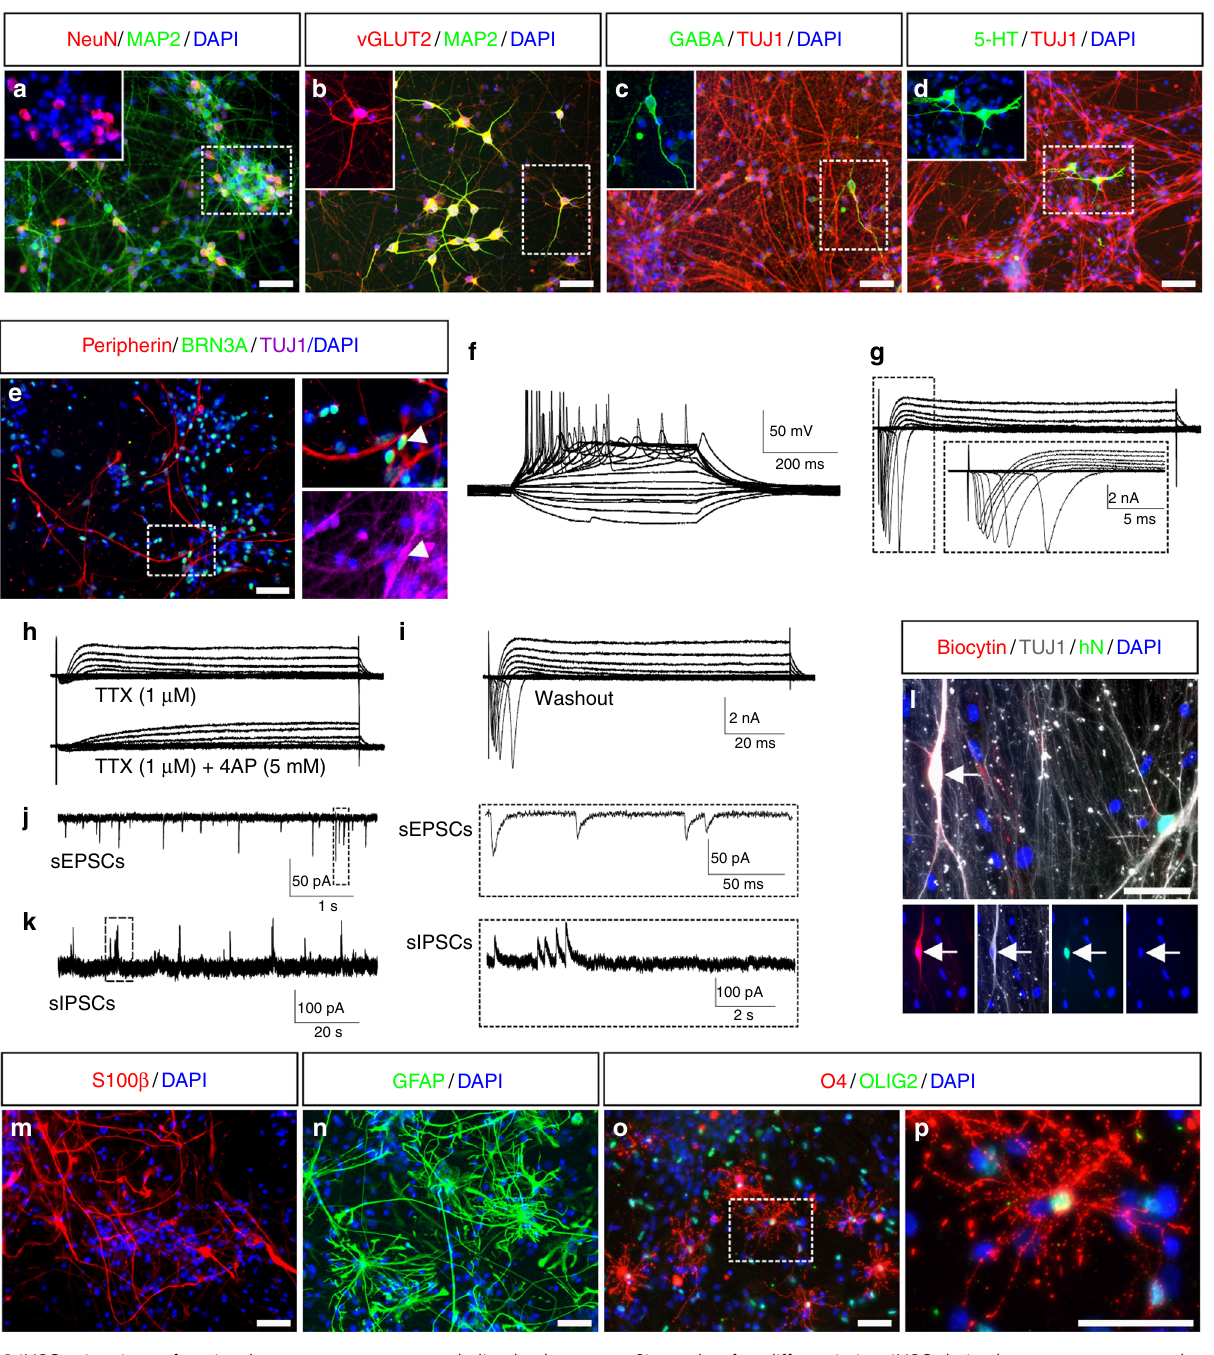
Fig. 2 iNSCs give rise to functional neurons, astrocytes, and oligodendrocytes. a Six weeks after differentiation, iNSC-derived neurons express markers of mature neurons such as MAP2 and NeuN. b – d Upon spontaneous differentiation, iNSCs give rise to vGLUT2-positive glutamatergic neurons ( b ). In addition, staining for GABA ( c ) or serotonin (5-HT, d ) can be detected. e Peripherin + /BRN3A + /TUJ1 + PNS neurons in 30-day-differentiated iNSCs. Arrowhead highlights an example of a triple-positive cell. f – l Whole-cell current clamp measurements reveal the generation of multiple action potentials upon depolarizing current injections ( f , n = 6/7). In response to depolarizing voltage steps, these neurons elicit fast and transient TTX-sensitive sodium- dependent inward currents and sustained 4-AP-sensitive potassium-dependent outward currents ( g – i , n = 6/6). Spontaneous postsynaptic currents are observed in whole-cell voltage-clamp recordings, indicating the in vitro formation of functional excitatory ( j , n = 6/7) and inhibitory ( k , n = 1/8) synapses. Post-hoc immunostaining reveals co-localization of biocytin, TUJ1, and the human-speci fi c marker hN in the recorded neurons (arrows, l ). m – p iNSCs give rise to S100 β + ( m ) and GFAP + ( n ) astrocytes as well as O4 + and OLIG2 + ( o , p ) oligodendrocytes. Scale bars: 50 μ